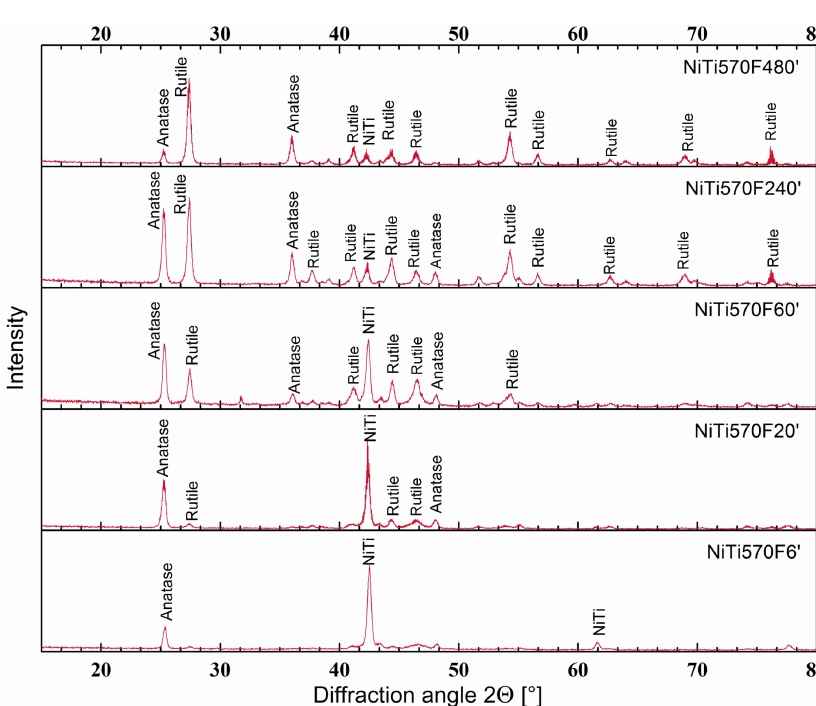
Figure 3. XRD patterns referents to 570 °C heat treated samples for 6, 20, 60, 240 and 480